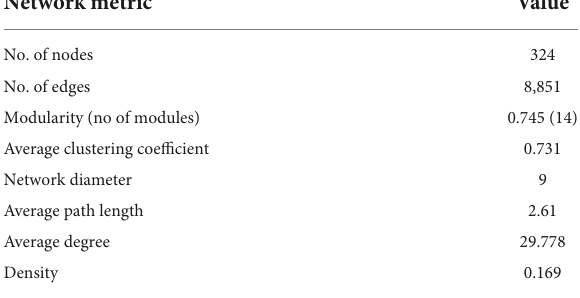
TABLE 3 Topological properties of community